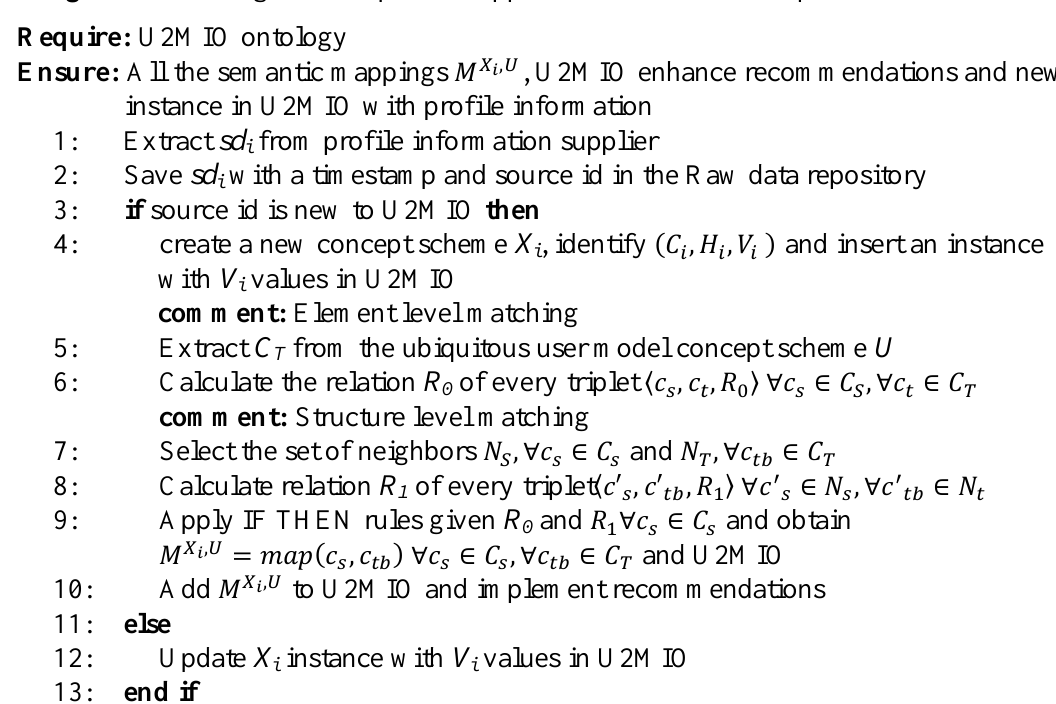
Algorithm 1. Integration of profile supplier information to ubiquitous user